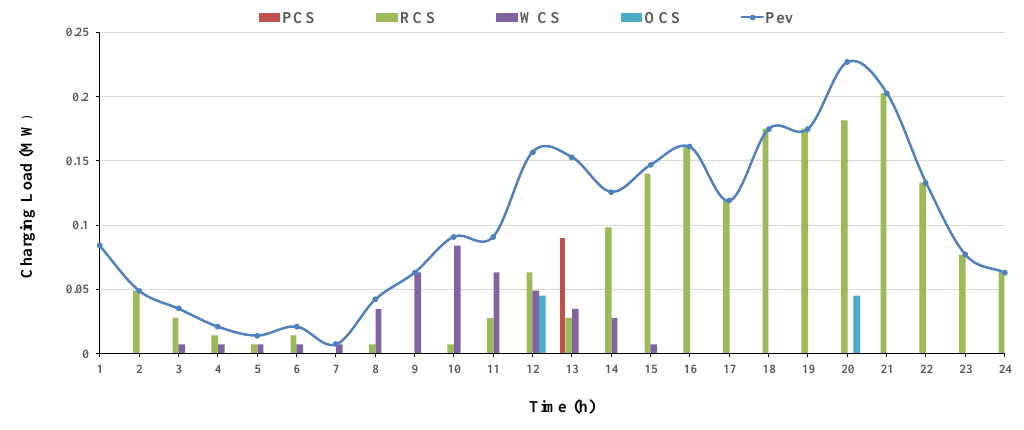
Figure 11. The optimal charging load of PEVs.